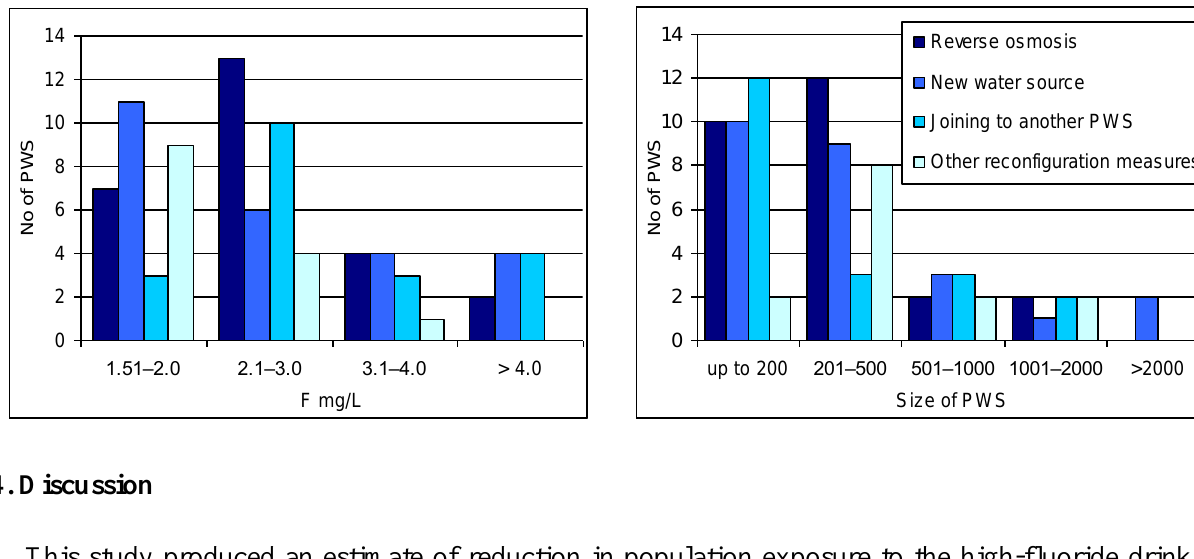
Figure 2. Implemented measures by the size of PWS and concentration of fluoride (exposure intensity) in drinking